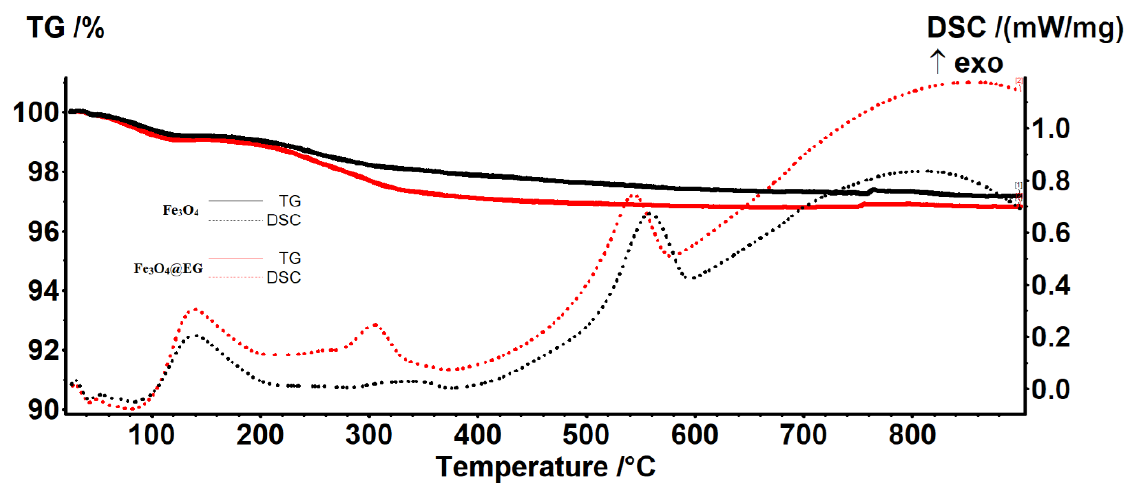
Figure 3. Thermal analysis of Fe 3 O 4 and Fe 3 O 4 @EG particles.